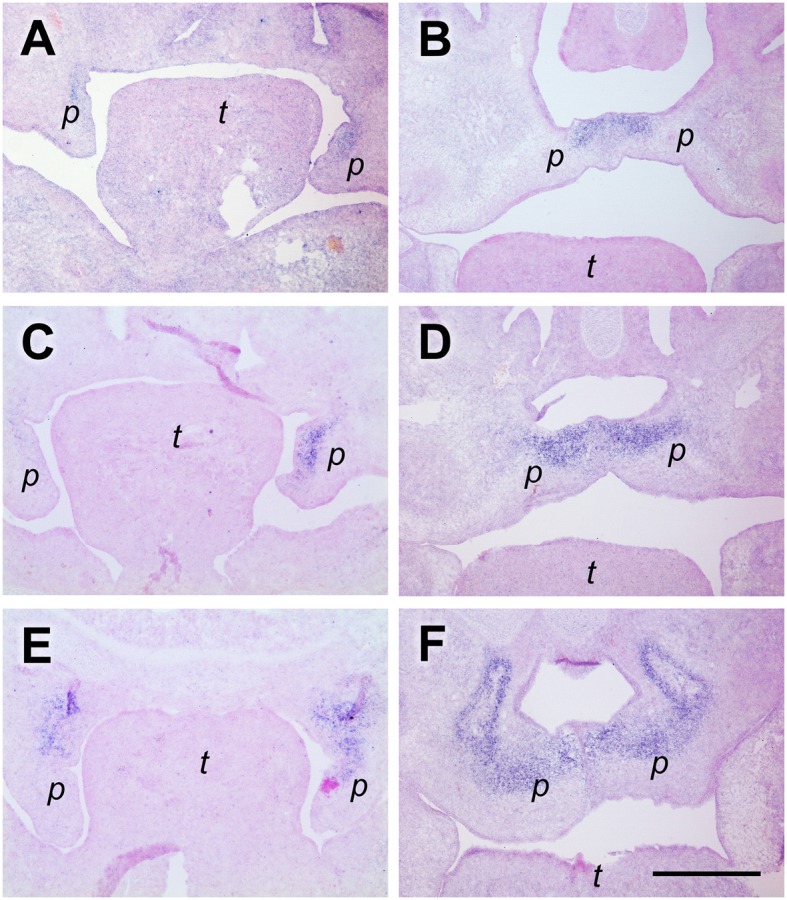
Tenascin-W expression in the dorsomedial quadrant of palatal shelves both before and after elevation. In situ hybridization for tenascin-W/Tnn mRNA on frontal sections of palatal shelves from wild-type mouse embryos at the anterior (A,B), medial (C,D), and posterior (E,F) level. Serial sections were obtained from an E13.5 (A,C,E) and an E14.5 (B,D,F) embryo, respectively. For description, see text. Abbreviations: palatal shelf (p), tongue (t). Bar, 400 μm.